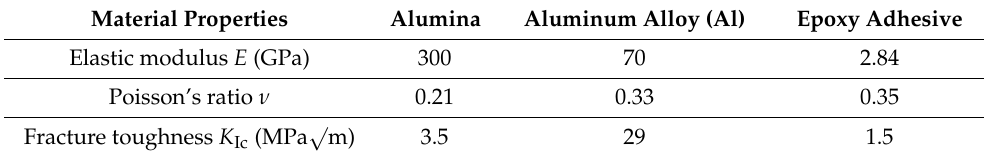
Table 1. Material properties of parts utilized for manufacturing the BISBB specimen